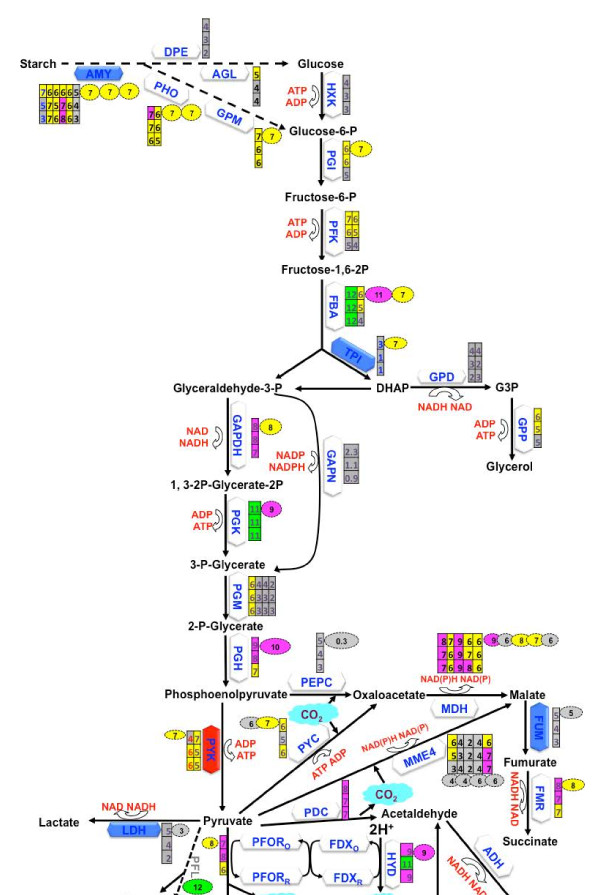
Starch catabolism, glycolysis and anaerobic fermentation pathways in C. moewusii constructed based on the information from C. reinhardtii and the transcript abundance of enzymes in C. moewusii and C. reinhardtii. Enzymes are represented by gray diamond boxes, except for PFL, whose gene sequence has not been identified in C. moewusii. The blue diamond boxes indicate that the respective gene is downregulated, and red color indicates upregulation. The numbers within the stacked rectangle boxes indicate the abundance of the respective transcript at Phase I, II and III, from top to bottom, respectively. Multiple columns were included for enzyme with multiple homologues. The numbers within the oval boxes represent the transcriptional abundance of homologous transcripts in C. reinhardtii. The abundance of each transcript is also represent by the color of the filled boxes, with green, pink or yellow indicating, respectively, the top 0.5%, 2.5% or 10% of all 1 transcripts, respectively.